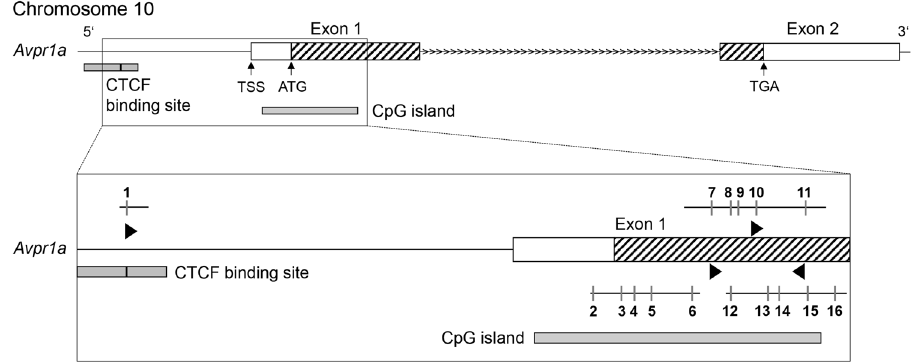
Figure 2. Map of the Avpr1a gene. Triangles indicate sequences analysed for DNA methylation. Vertical grey lines mark independent CpG sites (1–16). TSS = transcription start site; ATG = translation start codon; TGA = stop codon; CTCF = 11-zinc finger protein or CCCTC-binding factor (Figure created based on information from UCSC Genome Browser 69 , Ensembl 70 , and